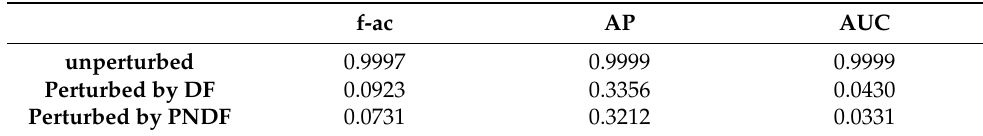
Table 2. Accuracy comparison of